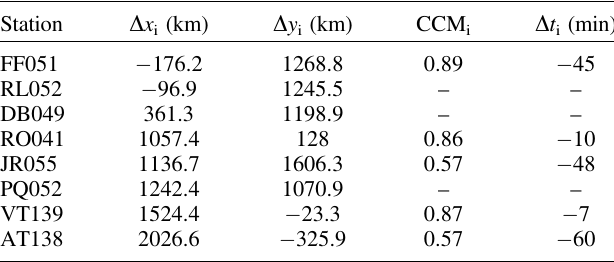
Table 2. Maximum correlation coef fi cients (CCM i ) and time delays ( D t i ) for 12 – 13 October 2015 event with EB040 as a reference